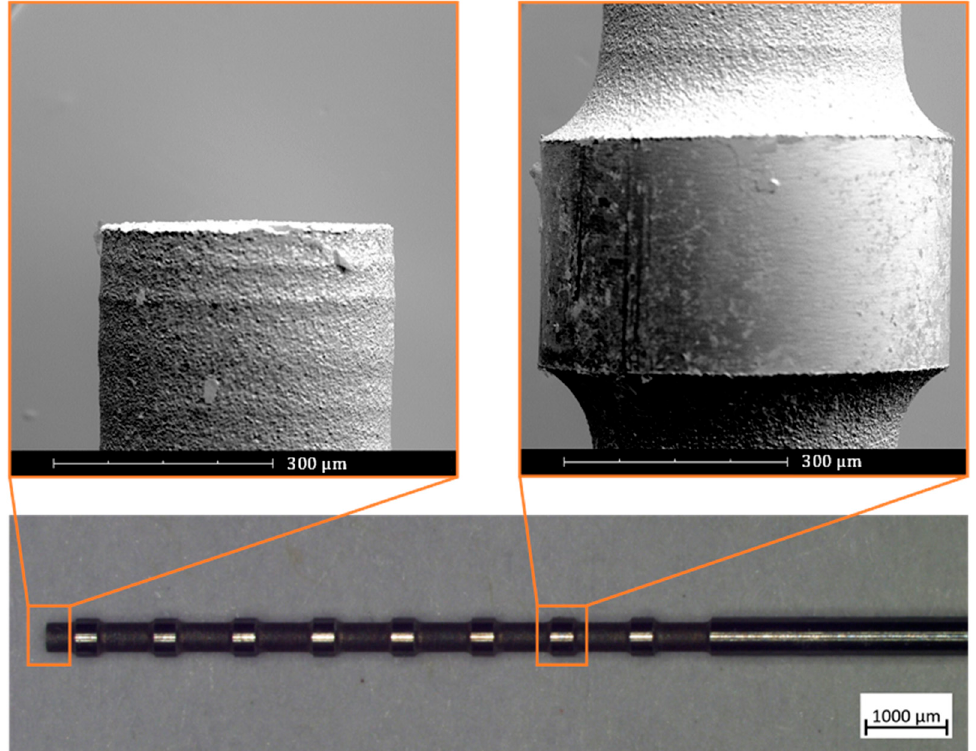
Figure 8. WEDG’ed microrod for moulding of soft pneumatic microactuators. The image of the microrod is taken using a ZEISS ® SteREO Discovery V20 optical microscope, while the enlarged views are taken by means of Phenom ® Pro scanning electron microscope.